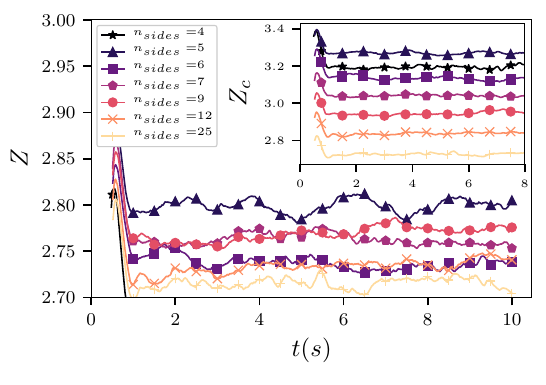
Figure 7. Evolution of the particle connectivity Z and Z c of non- breakable samples of regular polygons with di ↵ erent